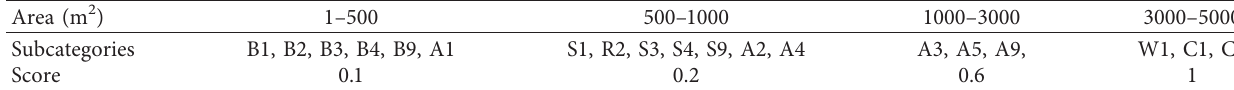
Table 2: General area score of POI subcategories.